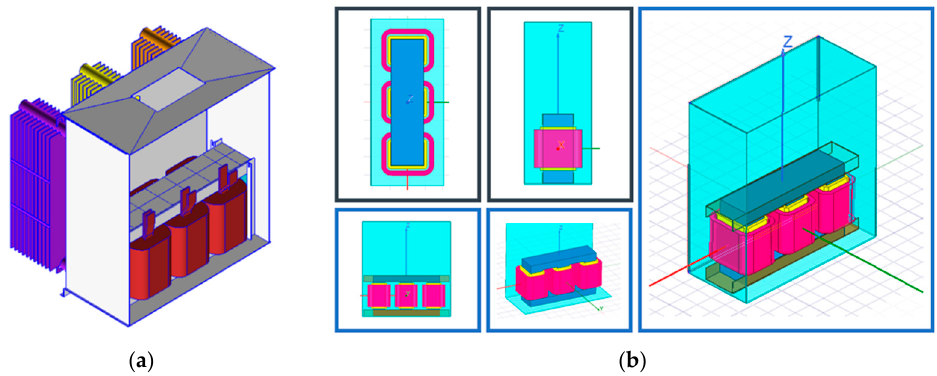
Figure 2. Standard design transformer 3D model for analysis: ( a ) transformer geometry using design system tool of the manufacturer; ( b ) equivalent geometry of the transformer in ANSYS Maxwell ® .